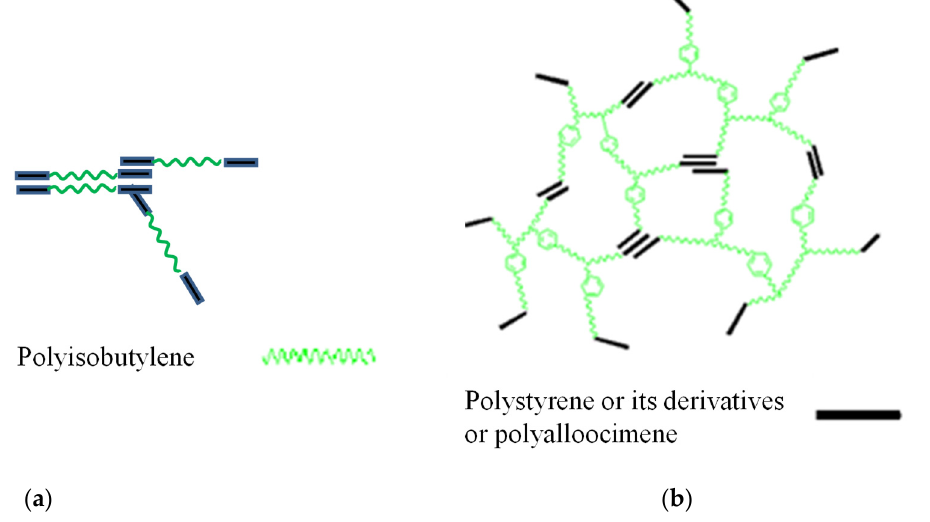
Figure 1. Sketch of the architecture and phase separation of L-SIBS and Allomatrix © ( a ) and Arbo- matrix © ( b